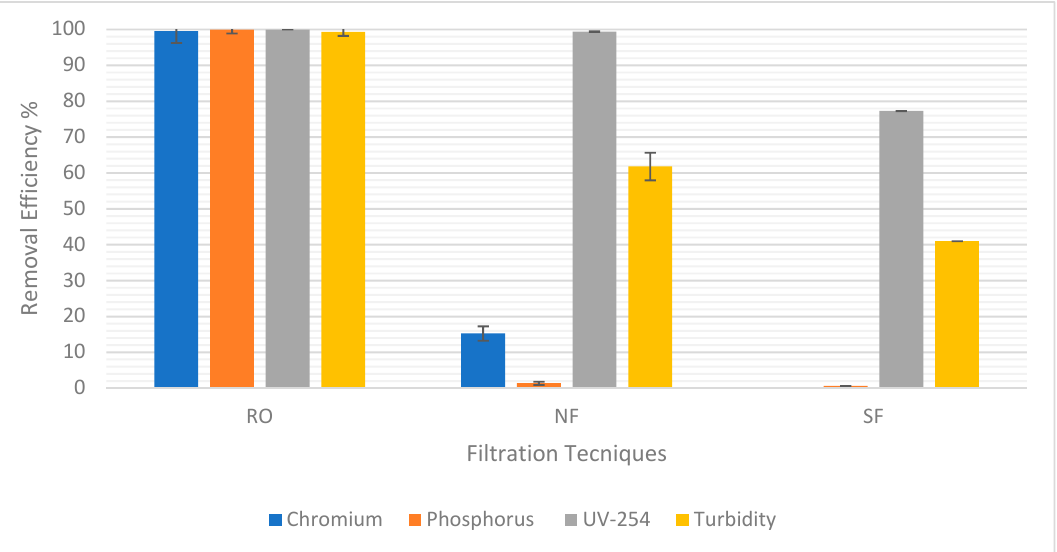
Figure 5. Efficiency Removal of Pollutants for each filtration technique. Table 3. pH Values.